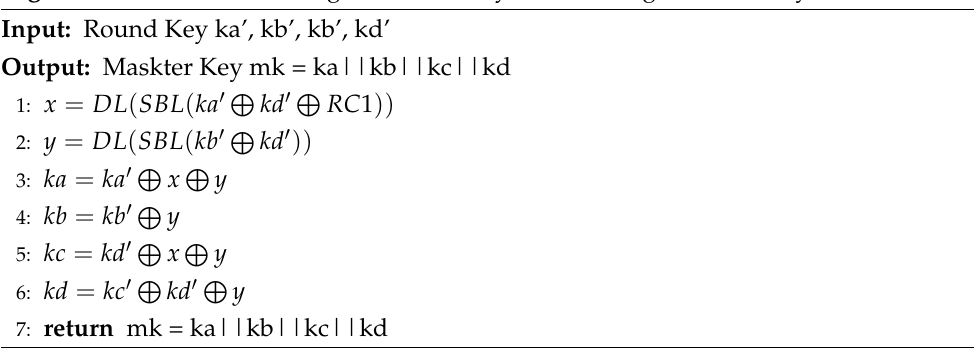
Algorithm 4 Process of finding the master key value through 4 round key values.